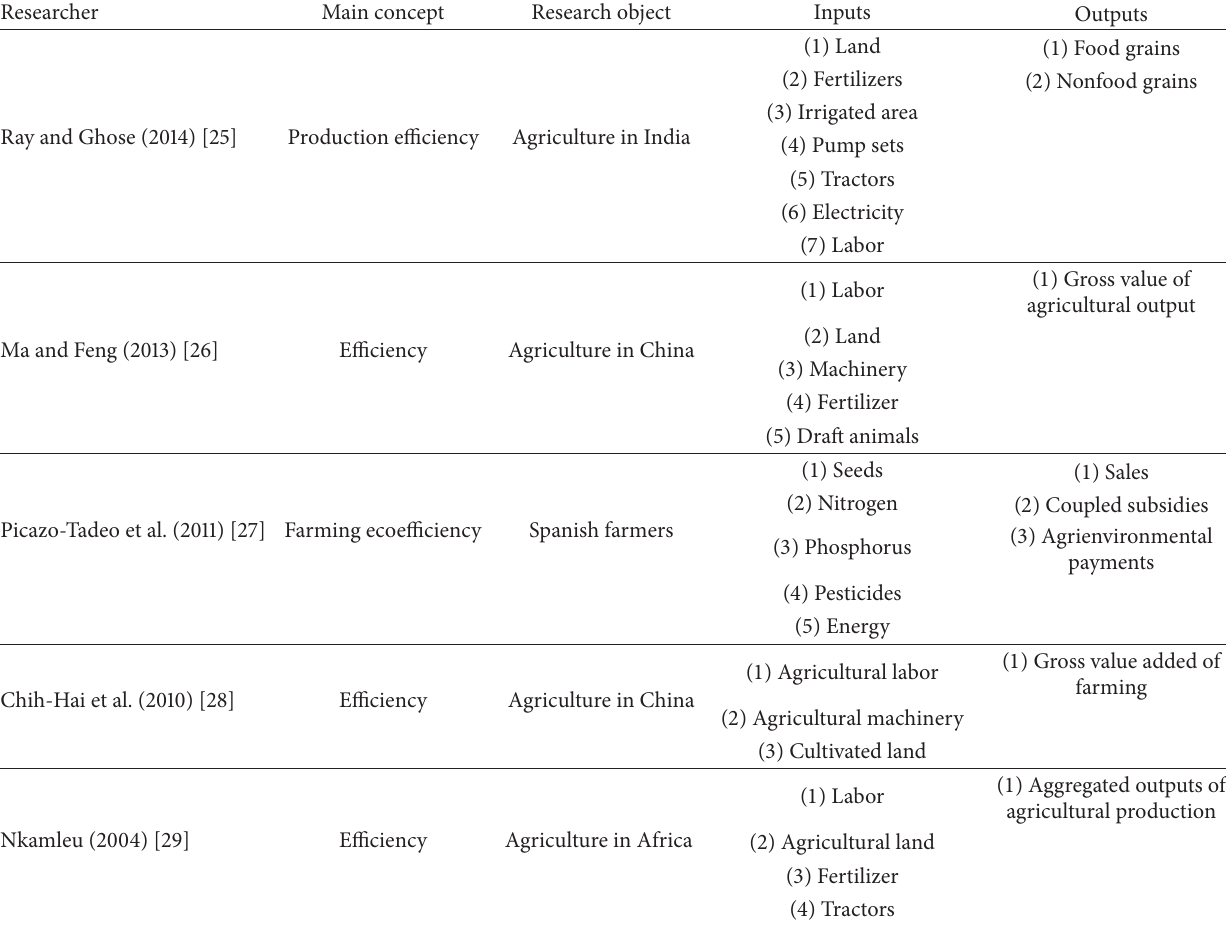
Table 1: Summary of inputs and outputs selected in previous